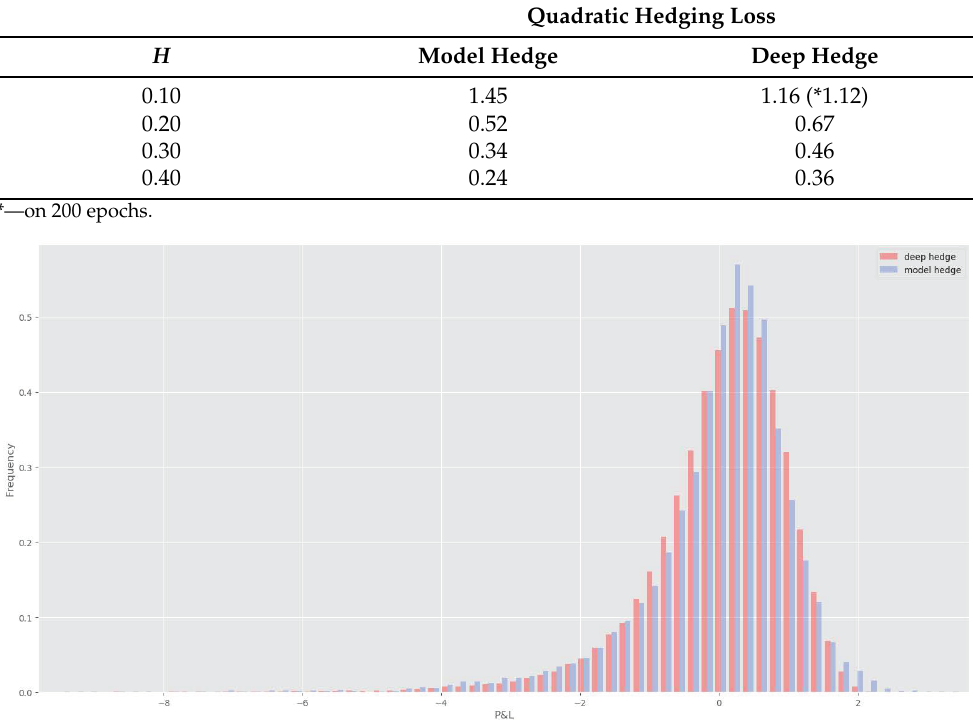
Figure 2. rBergomi model hedge (blue) compared to the deep hedge (red) trained on 75 epochs on rBergomi paths with H = 0.10. Note that the option price is only p 0 = 2.39 and that such a hedge can result in a substantial